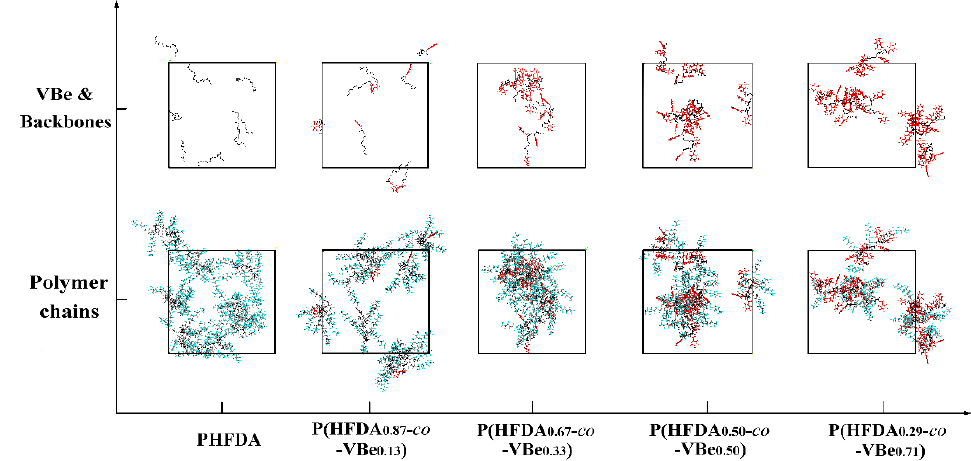
Figure 8. Equilibrium conformations of five CO 2 –polymer systems at 308.2 K and 25 MPa. All the CO 2 molecules were deleted to highlight the polymer chains ( lower ) and the specific functional groups and backbones ( upper ).